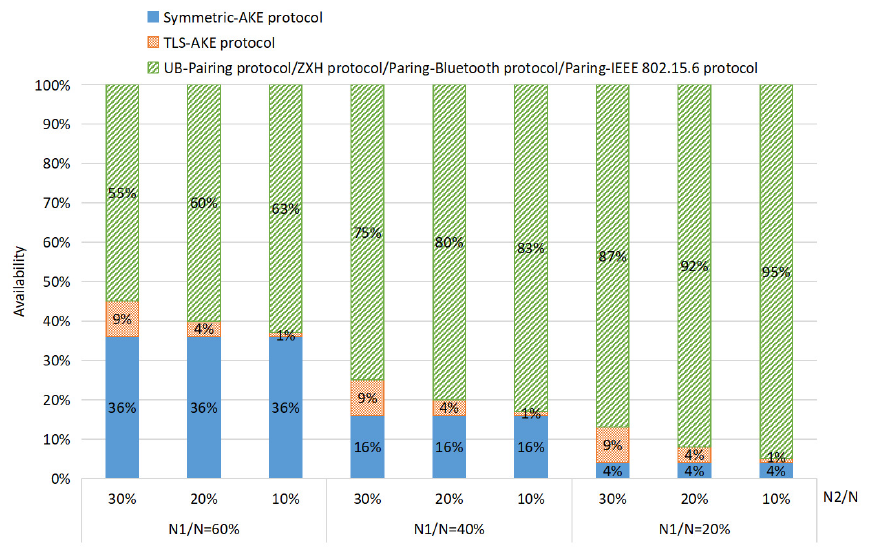
Figure 8. Availability results